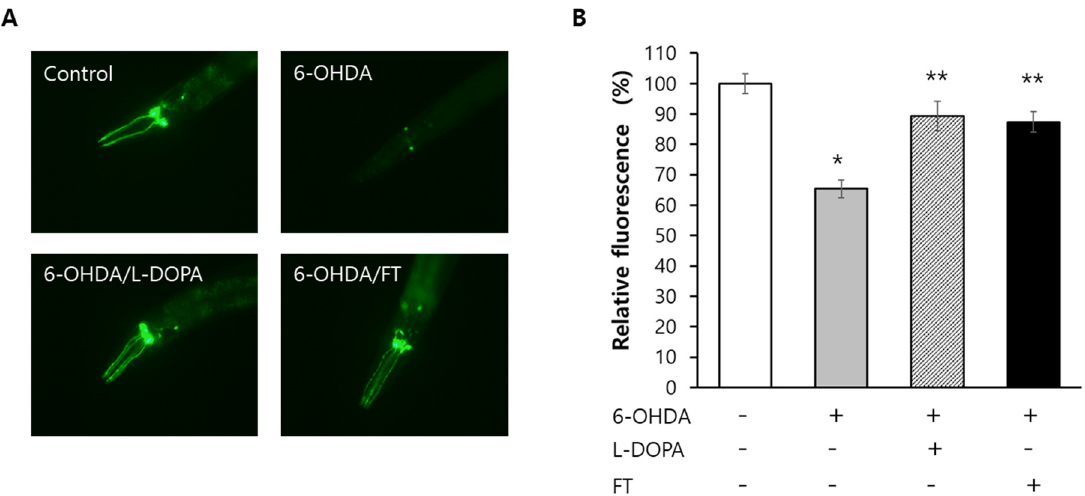
Figure 4. Recovery of degeneration in dopaminergic neurons by fisetin. ( A ) Expression of GFP in dopaminergic neurons was shown in untreated control. Experimental groups were treated with different combinations of 6-OHDA, L-DOPA, and fisetin. ( B ) Fluorescence observed in each group was quantified using Image J program and relative percent fluorescence was compared to untreated control. Error bar indicates standard error. 6-OHDA, 6-hydroxydopamine; L-DOPA, L-3,4-dihydroxyphenylalanine; FT, 0.1 g/L of fisetin; *, significantly different compared to untreated control ( p < 0.05); **, significantly different compared to 6-OHDA-treated group ( p < 0.05).